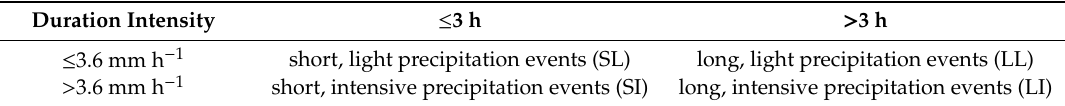
Table 1. Classification of precipitation events with regard to duration and